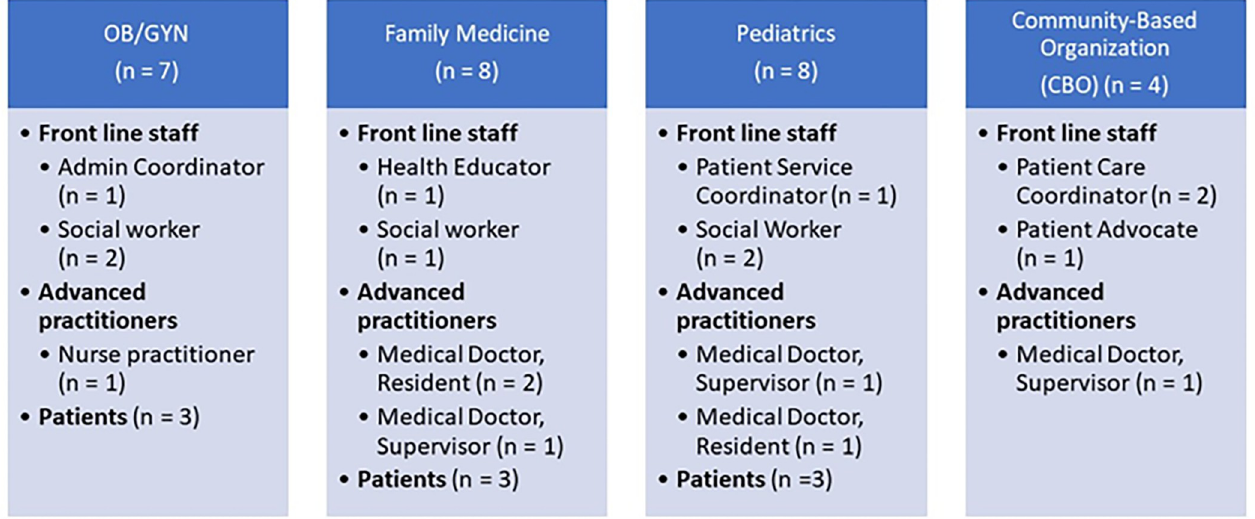
Fig 1. Interview participants by department and